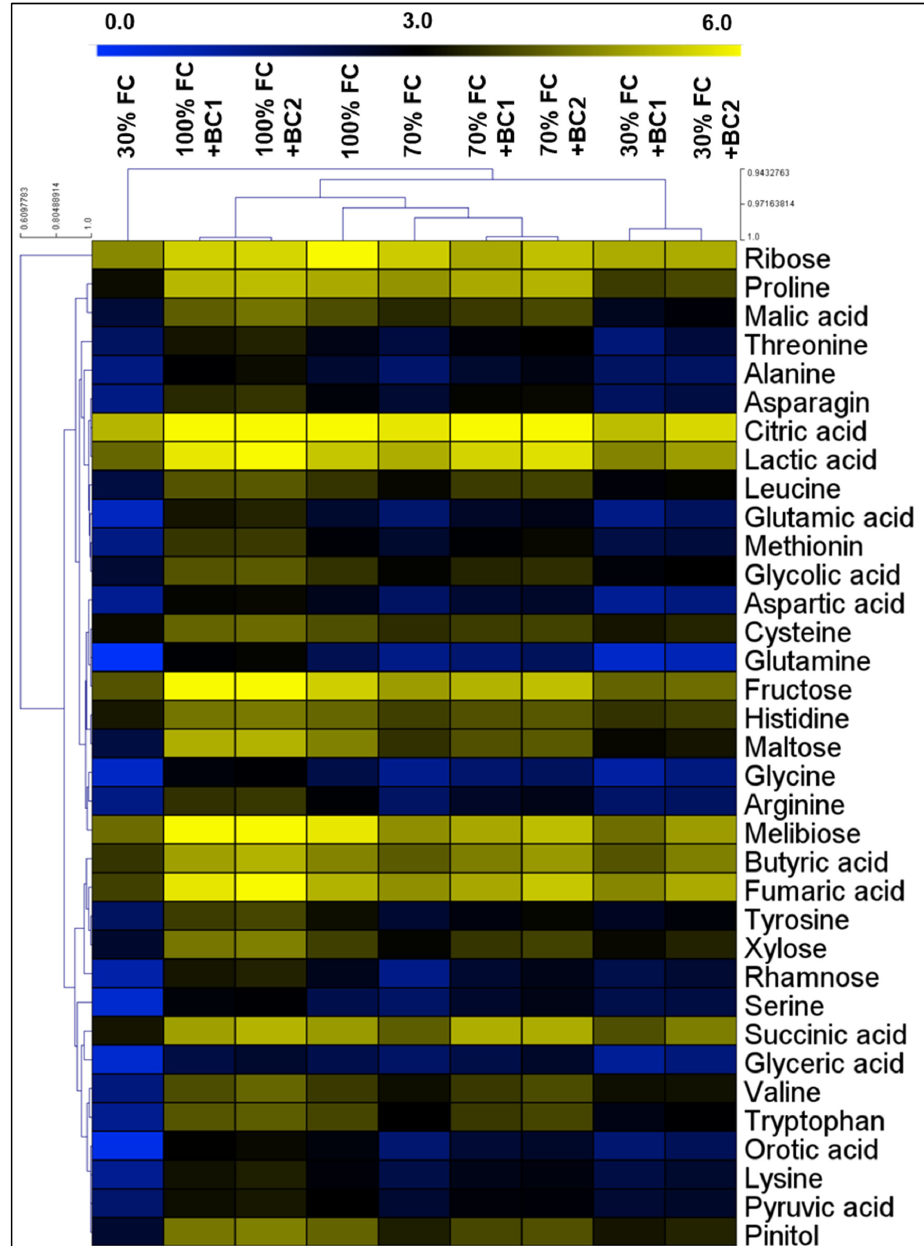
Figure 6. Biochar-dependent alterations in the metabolite levels of drought-stressed L. fusca shoots. The heatmaps were developed by Multiviewer Experiment software by using log-2 values. In addition, FC and BC represent field capacity and biochar, respectively.